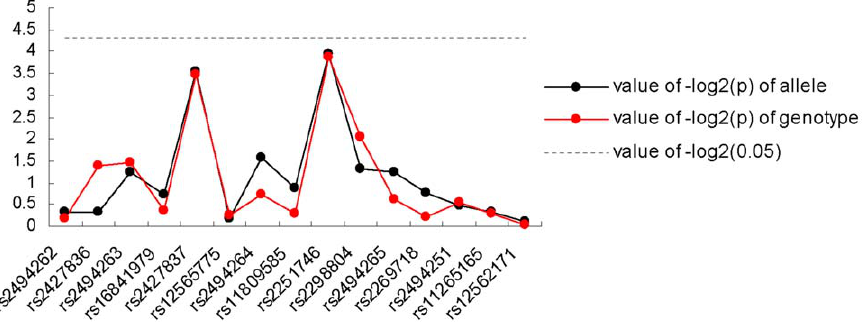
Figure 2. Significance of each tagging SNP. The x axis shows the genomic position, and the y axis shows the negative base-10 logarithm of the P values for each allele and genotype of each SNP. Lines are drawn between points only for the sake of clarity, as the disease association between markers is not linear. doi:10.1371/journal.pone.0015792.g002 PLoS ONE |